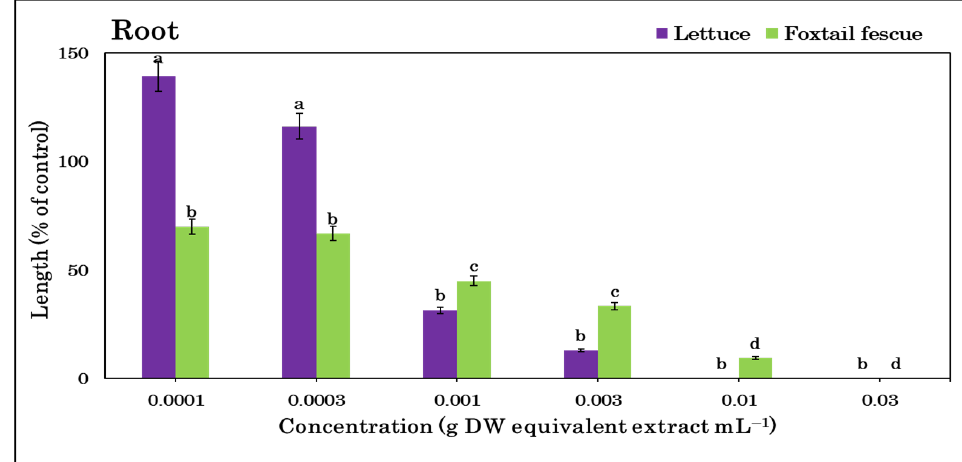
Figure 4. T. nudiflora leaf extract treatment at various doses inhibited the root growth of the test plants. Mean ± SE of two independent experiments repeated three times. Vertical bars illustrate the standard error of the mean. Different letters stand for differences between the control and T. nudiflora treatments (Tukey’s HSD at p ≤ 0.05).